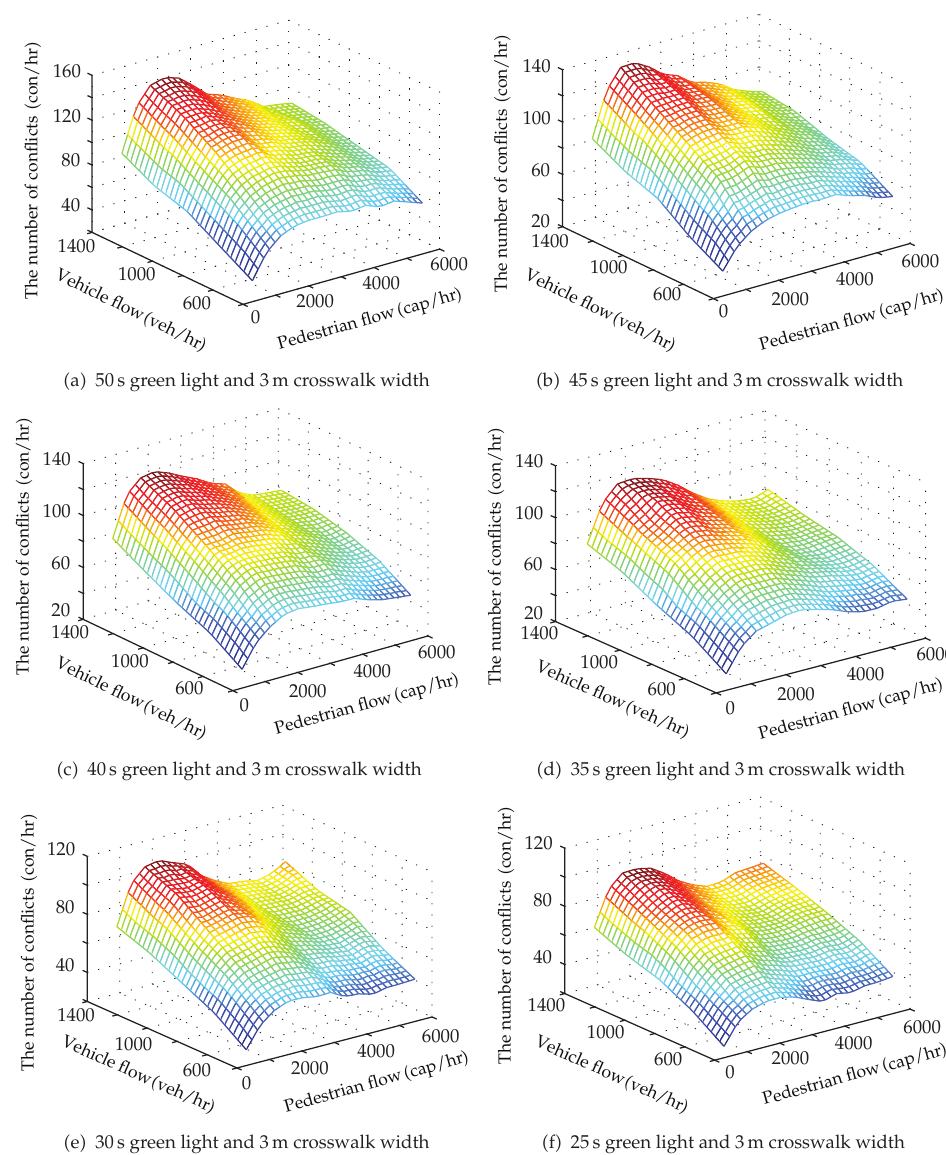
Figure 5: Relationship among pedestrian flow, vehicle flow, and the number of conflict events between pedestrians and vehicles for di ff erent types of pedestrian green